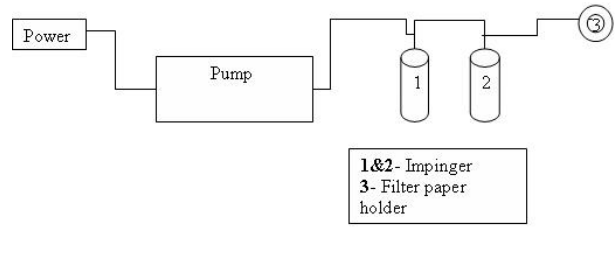
Fig. 2. Flow diagram of sampling assembly.